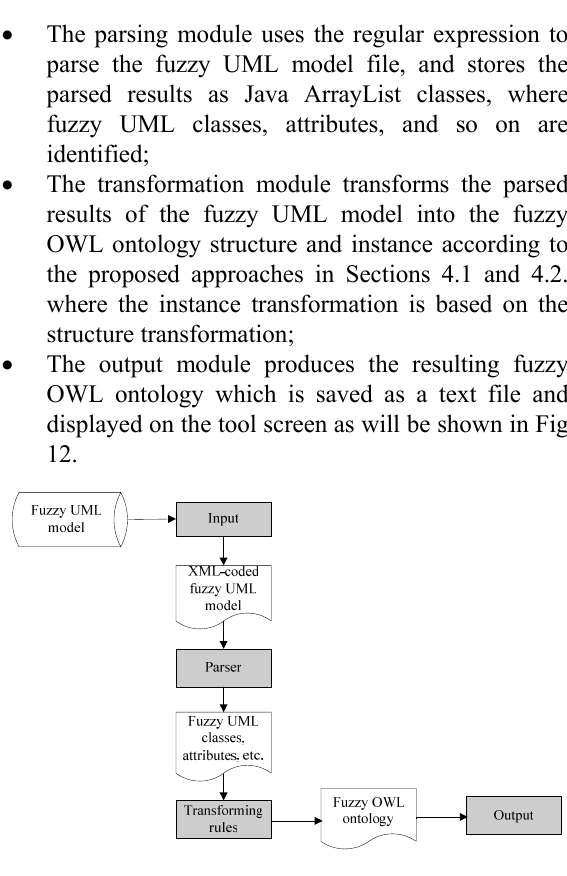
Fig. 11. The overall architecture of FUML2FOnto